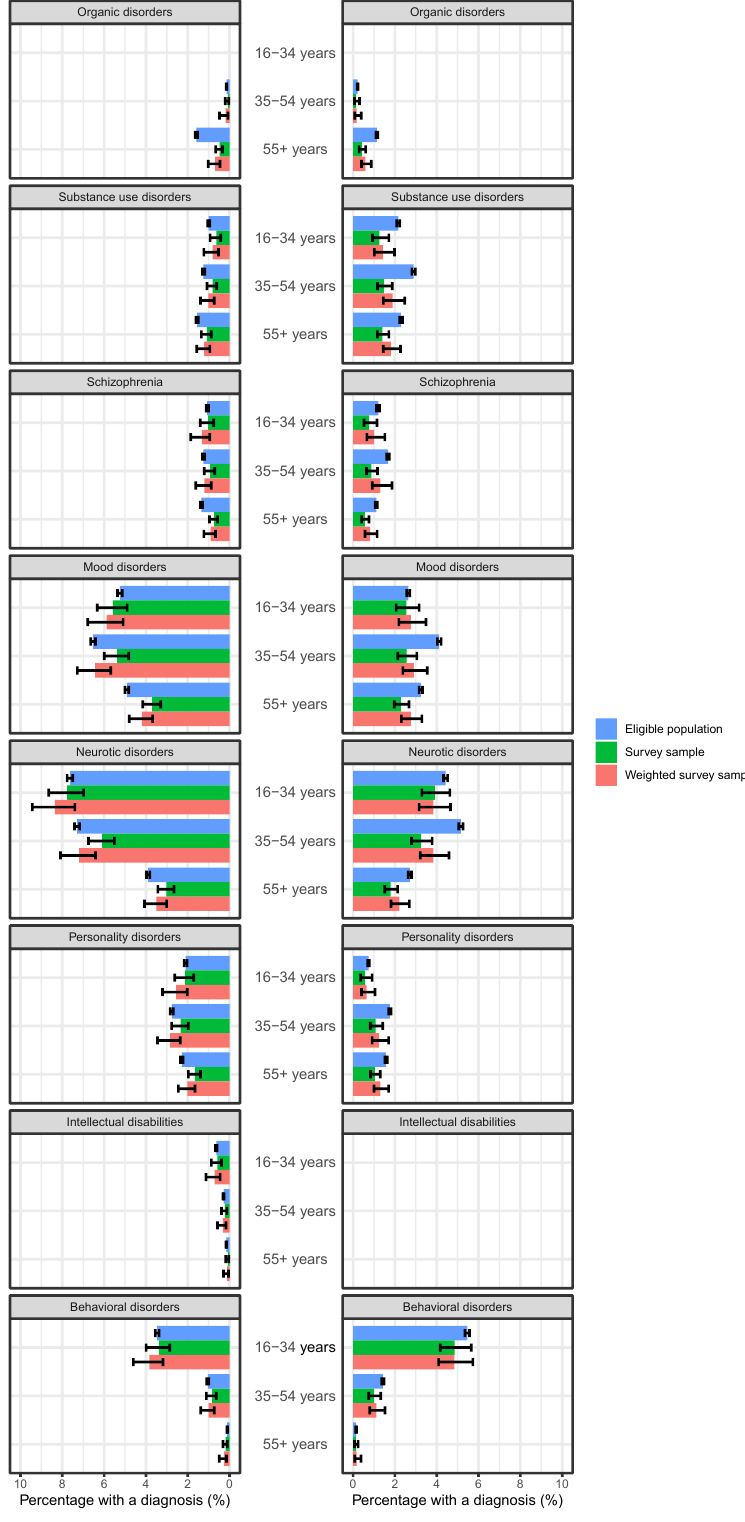
NB. None of the proportions for mental disorder types for a sex are shown if any of the age-groups comprised fewer than 5